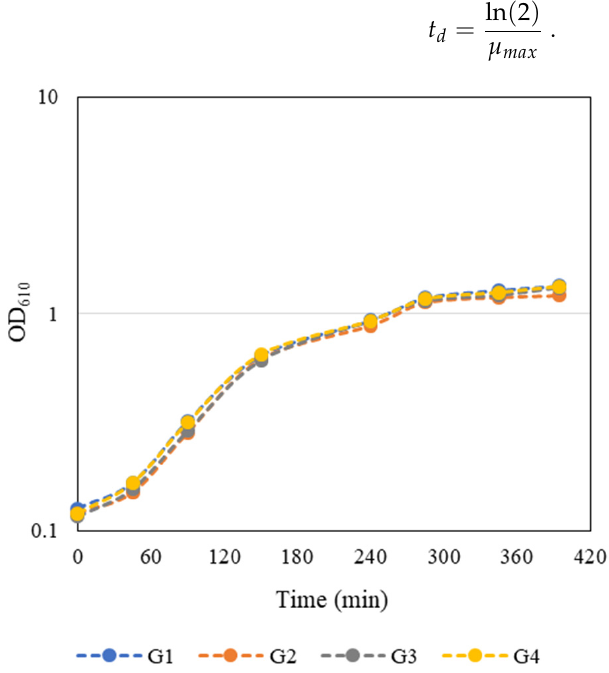
Figure 3. Student-generated growth curves of E. coli JM109(DE3) harbouring the pFM23 plasmid. After 180 min of incubation, IPTG was added to the culture medium. Table 2. Parameters obtained by regression analysis for each